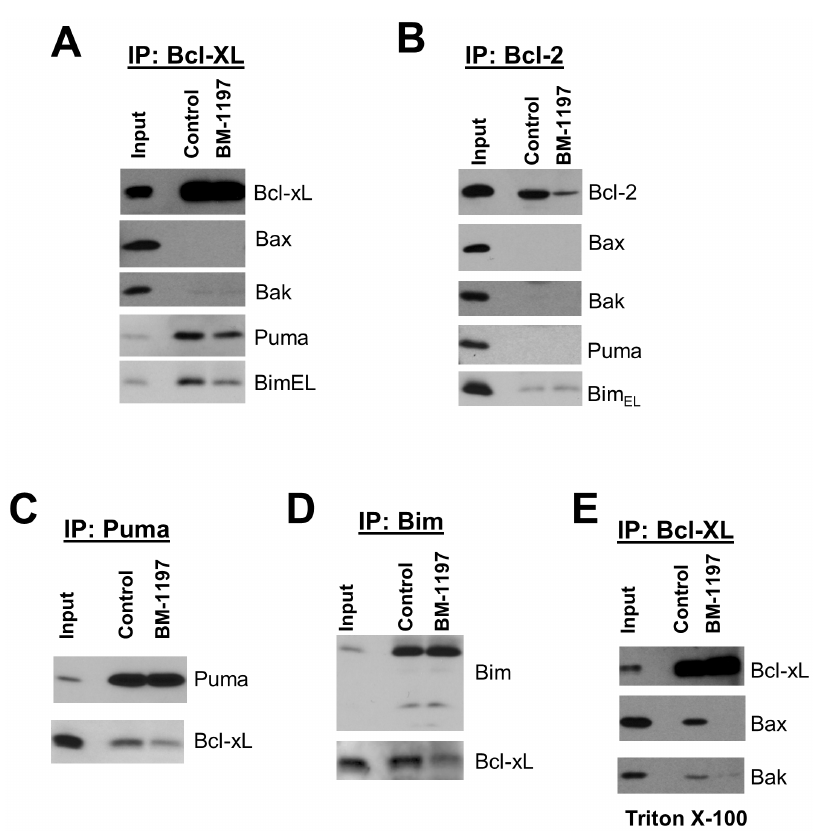
Figure 7. BM-1197 disrupts the association between BCL-XL and PUMA or BIM in H146 cells. (A–D) H146 cells were treated with DMSO (control) or BM-1197 (100 nM) for 2 h and CHAPS lysed whole cell extracts were immunoprecipitated with the indicated antibodies. The immunoprecipitates were analyzed by immunoblotting with the indicated antibodies. (E) H146 cells were treated with DMSO (control) or BM-1197 (100 nM) for 2 h and Triton X-100 lysed whole cell extracts were immunoprecipitated with anti-Bcl-xL antibody. The immunoprecipitates were analyzed by immunoblotting with the indicated antibodies. doi:10.1371/journal.pone.0099404.g007 PLOS ONE |